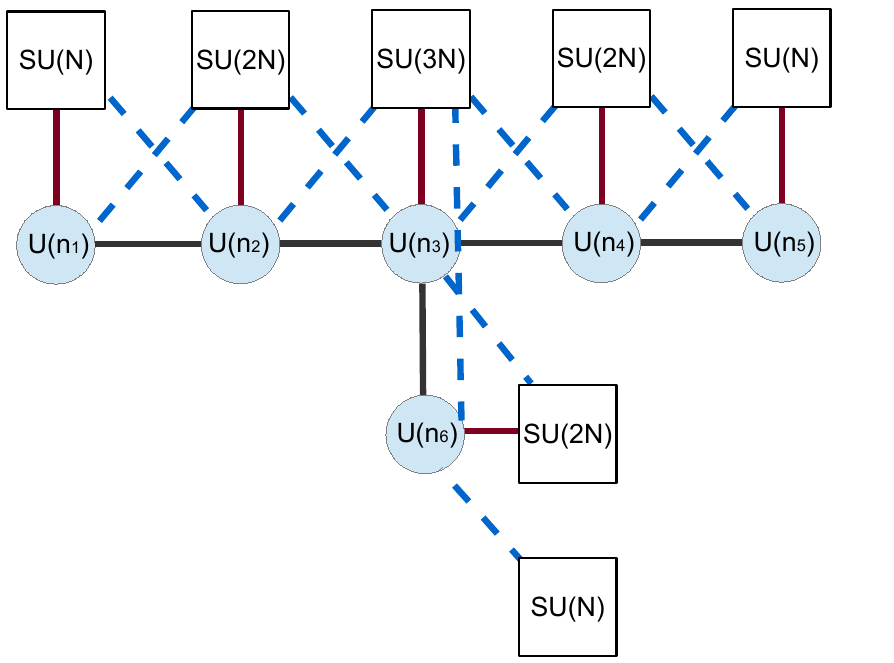
Figure 12 . Quiver gauge theory for the non-critical strings of N D5 branes probing an E singularity.